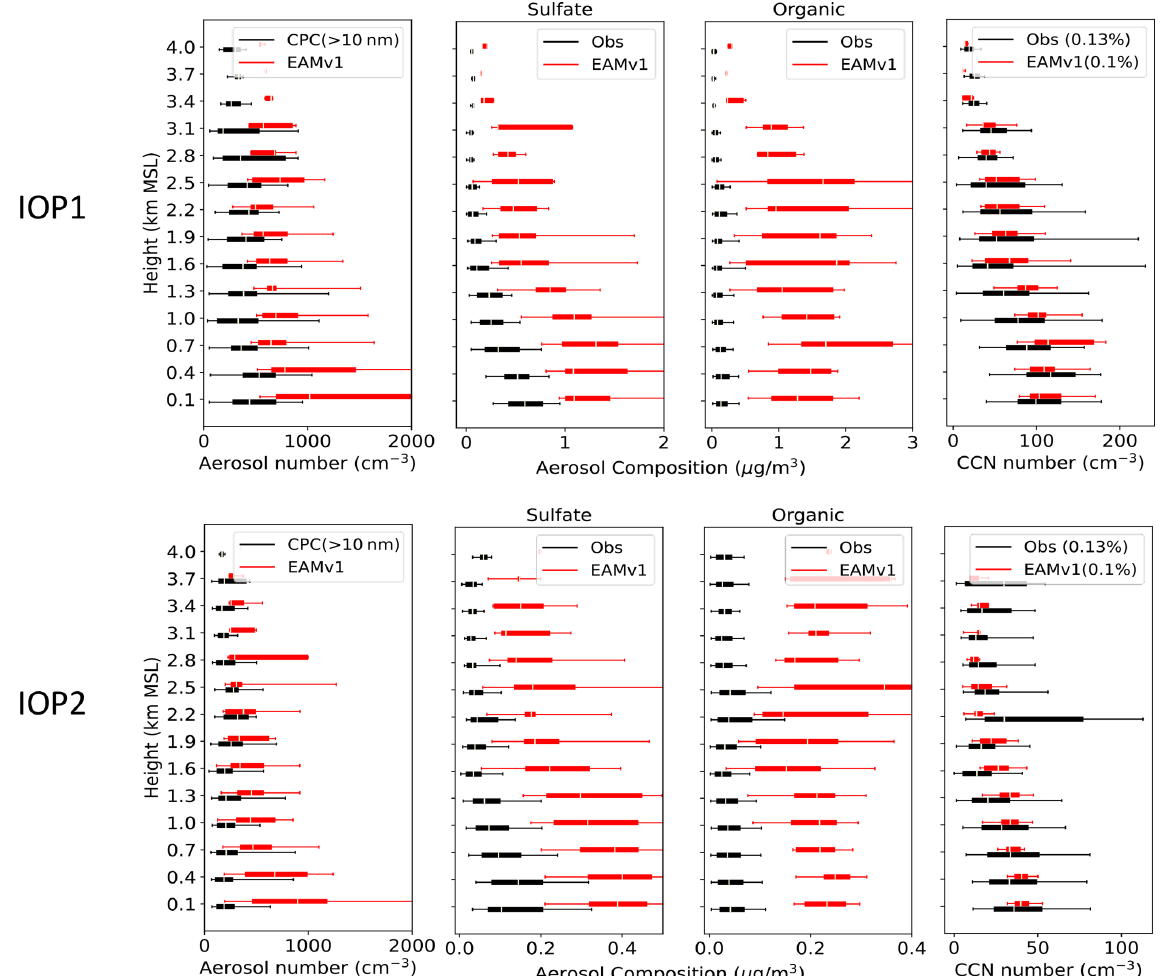
Figure 9. Same as Fig. 7 but for